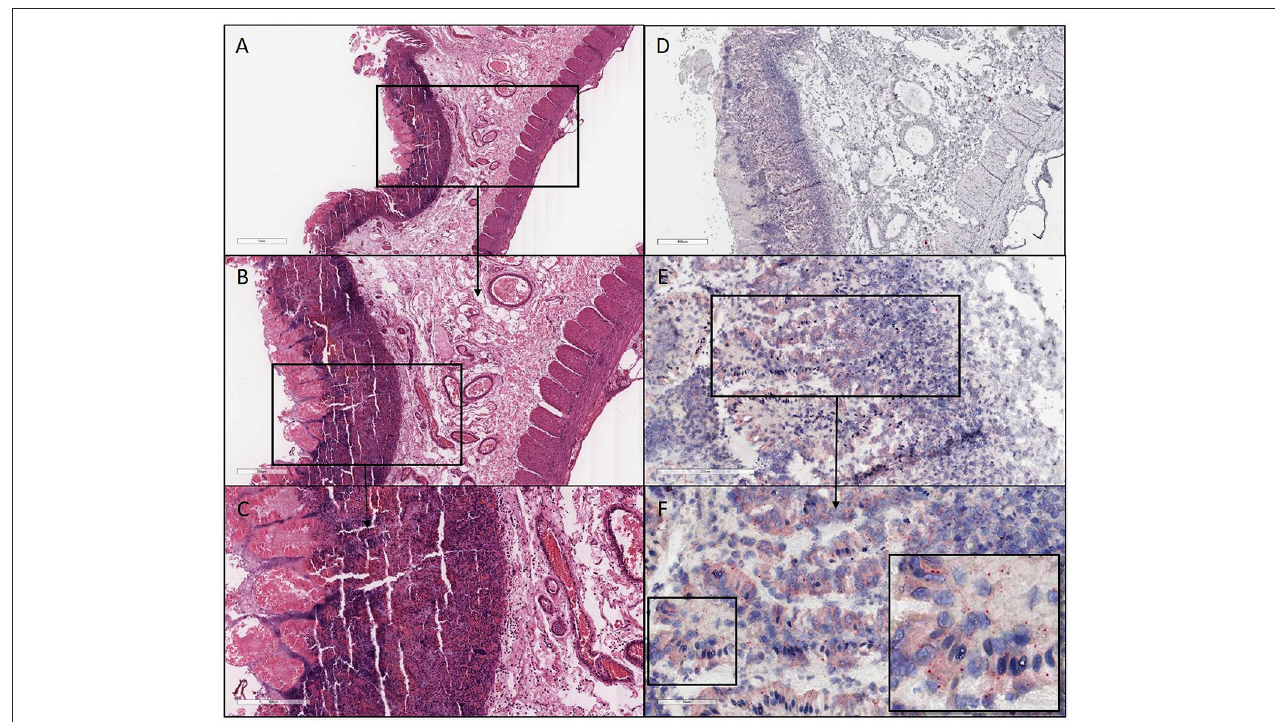
FIGURE 5 | H&E and ISH images of patient #4 in focal mucosal ulcer with granulation tissue formation. (A–C) H&E images of ischemic colon tissue sections at 2X, 4X, and 10X magnification, respectively. (D–F) Images at lower (4X) and higher magnification (20X and 40X), respectively, after in situ hybridization using V-nCOV2019—orf1ab–sense probe (red chromogen) illustrating replicating SARS-COV-2 RNA was